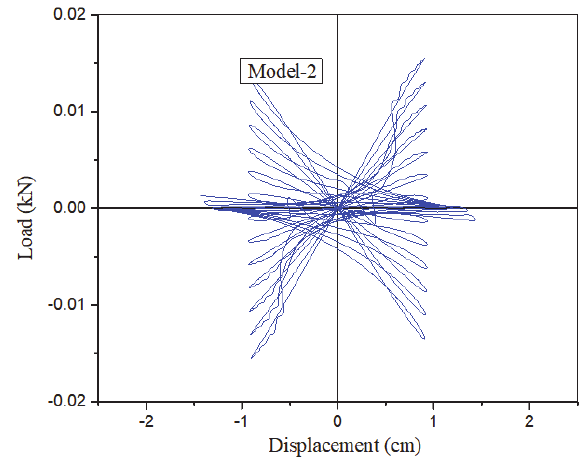
Figure 5: Load Vs displacement on timber beam with 3.3 (m) length, model-1.